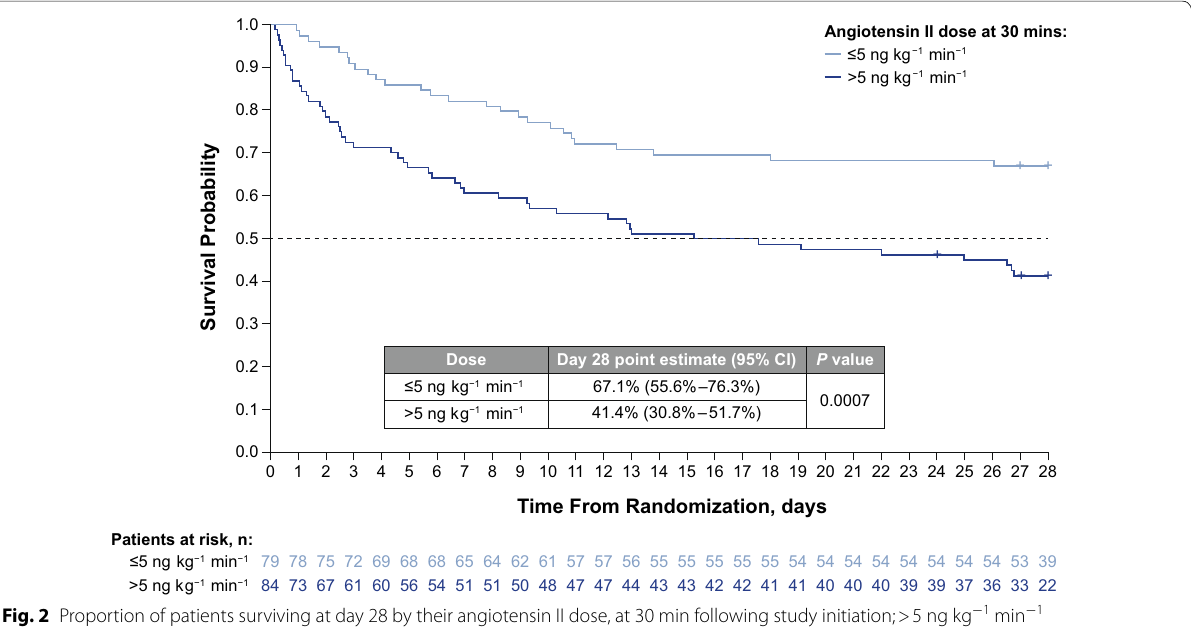
Fig. 2 Proportion of patients surviving at day 28 by their angiotensin II dose, at 30 min following study initiation; > 5 ng kg − 1 min − 1 versus 5 ng kg − 1 min − 1 . CI, confidence ≤